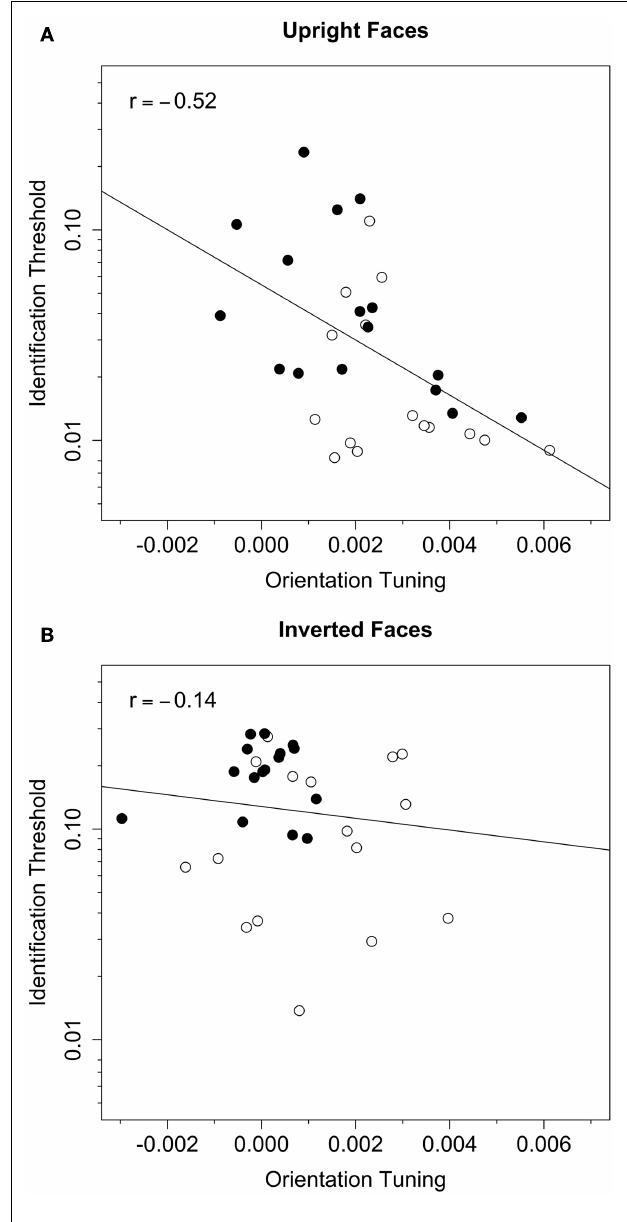
FIGURE 6 | Identification threshold plotted against orientation tuning for upright (A) and inverted (B) faces. Data from the t 67 and t 50 groups are represented by the filled and open symbols, respectively.The dotted line represents the best-fitting (least-squares) line fit to the data from both groups.The Pearson correlation between identification threshold and orientation tuning was significant for upright ( r =− 0.52) but not inverted ( r =− 0.14)